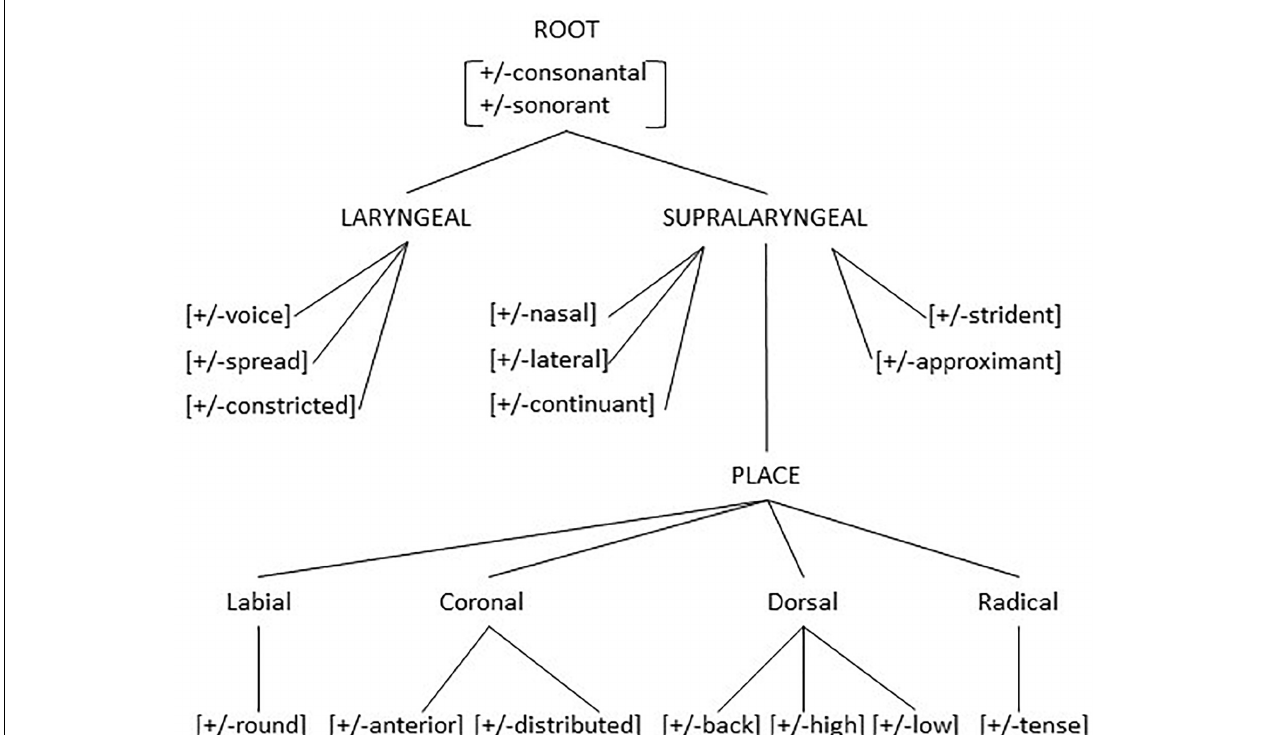
FIGURE 4 | Feature